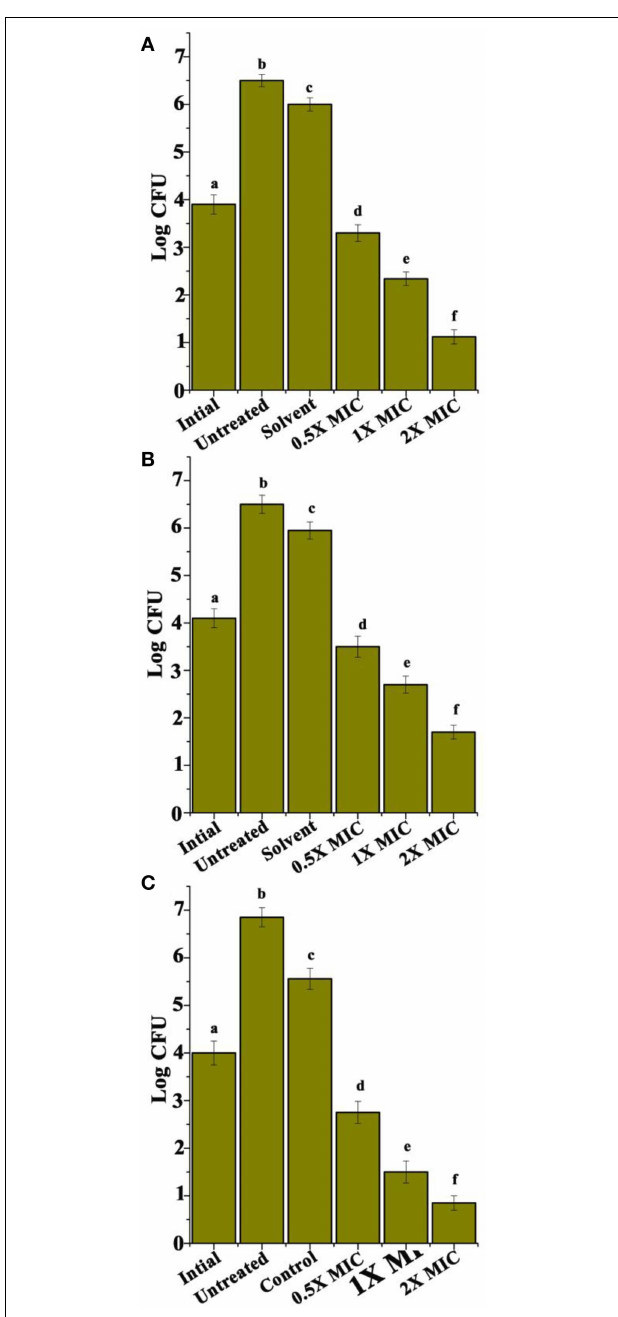
FIGURE 6 | Intracellular efficacy of rifampicin in J774 murine macrophage. (A) CDP 1, (B) CDP 2, and (C) CDP 3. Experiments were performed three times. Error bars indicate the standard deviations of three measurements. Different letters in the superscript were significantly different according to Duncan’s multiple range test ( p < 0.05).